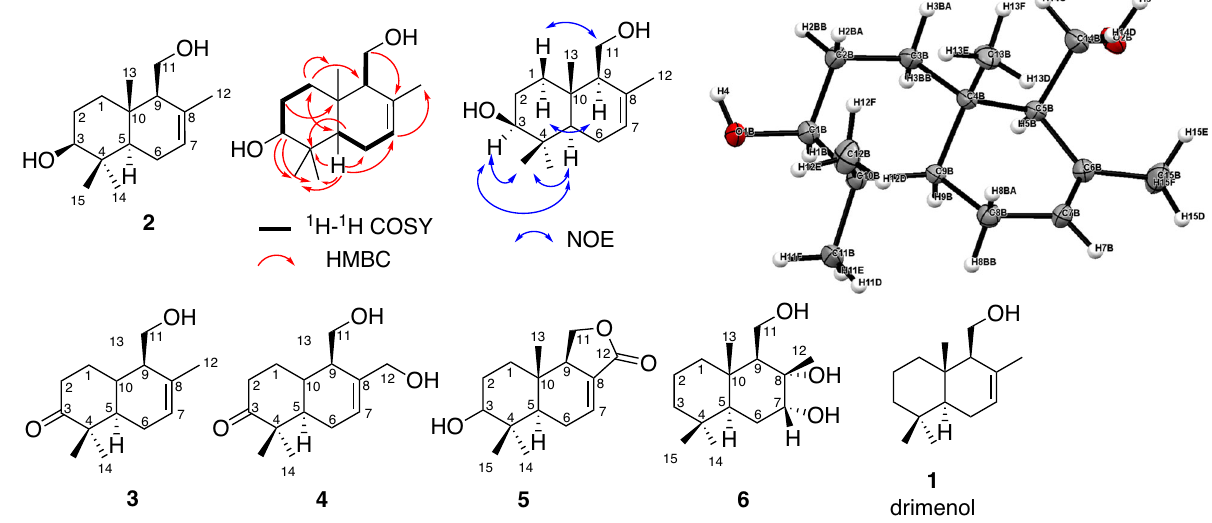
Fig. 3 Chemical structures of detectable and isolated sesquiterpenes 1, 3-6 from T. cryptogamus strain T153 with atom numbering. Drimenol derivative 2 with key COSY, HMBC and NOE correlations. Molecular structure with ellipsoids represents a probability of 30 %, H atoms are drawn with arbitrary radii, carbon atoms = gray, oxygen atoms = red, hydrogen atoms =